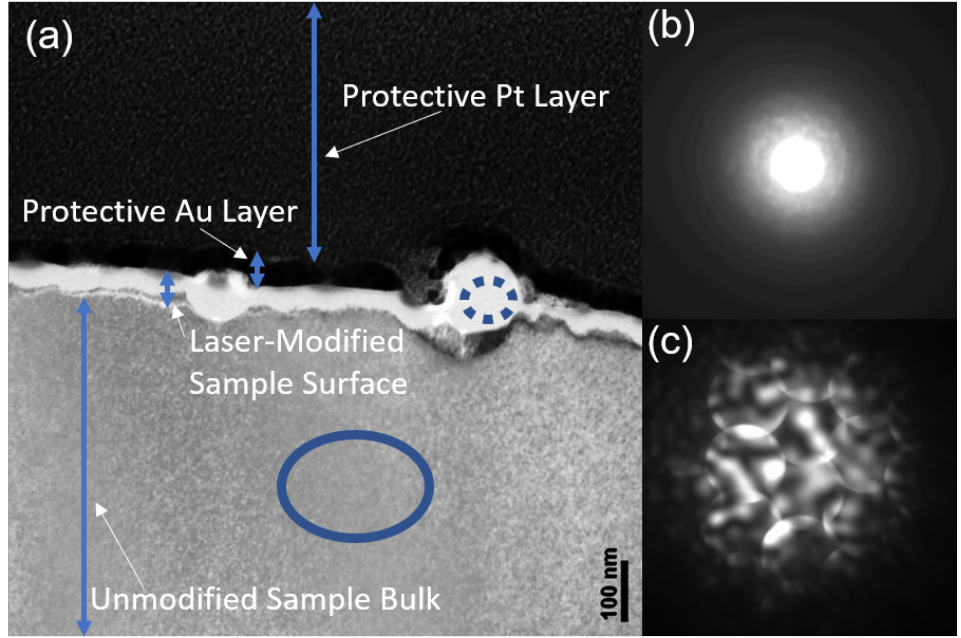
Figure 10. Electron diffraction and cross-sectional TEM measurements of multi-pulse LID on silicon. The different layers in the image are labeled in ( a ); ( b ) shows the result of electron diffractometry performed in areas like the blue dotted circle, i.e., on a nano-outgrowth; ( c ) shows the result of electron diffractometry performed in areas like the solid blue circle. It shows a strong crystalline ordering. In contrast, a strong amorphous signal is observed in ( b ). This means that, in the sample, the brighter white areas correspond to amorphized material while the gray/dark areas in the bulk correspond to monocrystalline silicon